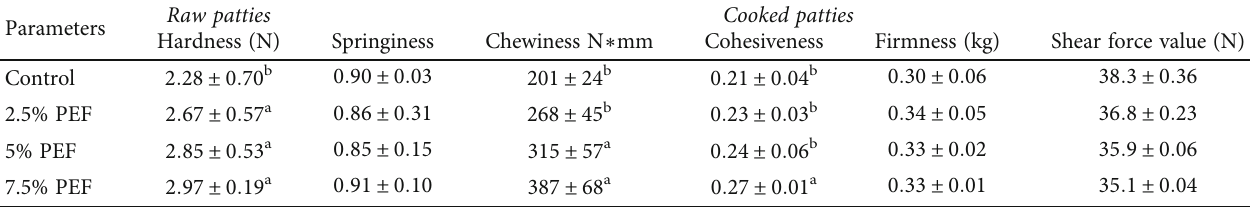
Table 4: Instrumental textural properties of raw and cooked beef patties containing di ff erent concentrations of PEF.